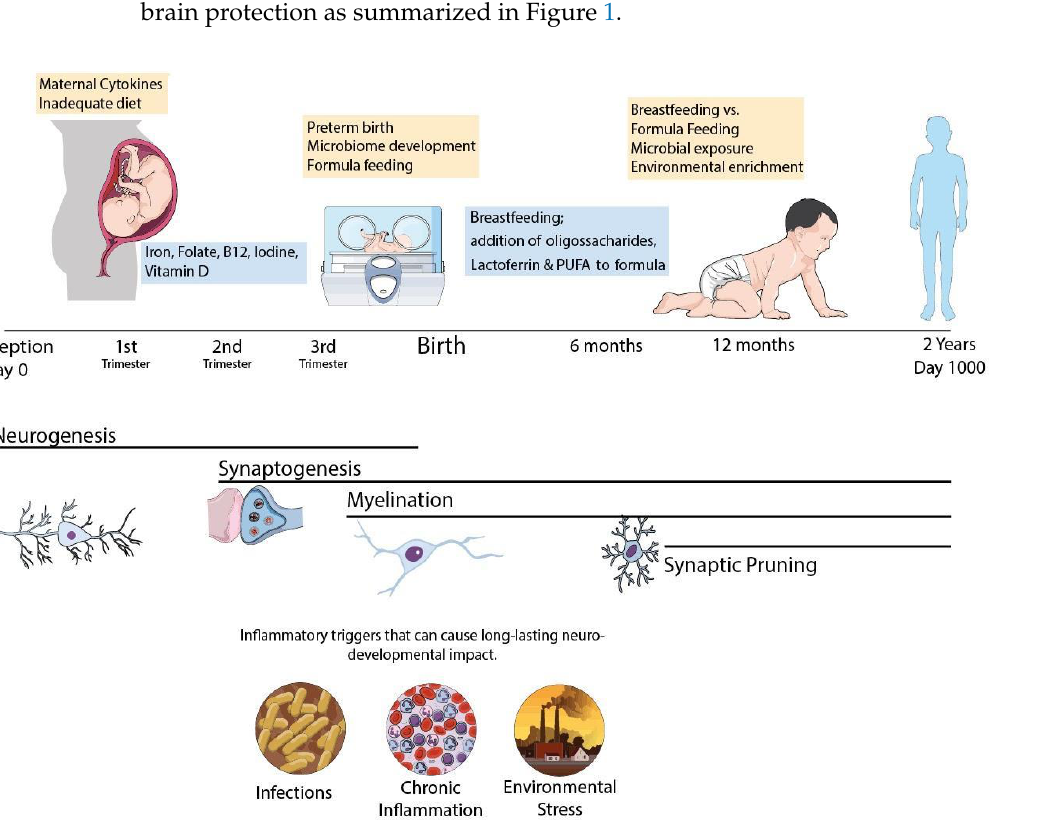
Figure 1 - Schematic representation of the CNS development in the first 1000 days period. Infant’s brain undergoes major hallmarks of neurodevelopment during this period and can be affected by poor nutrition, infectious pathogens and pollutants with life lasting consequences. Common neurodevelopmental disorders involve myelination disturbances (IUGR, prematurity) or synaptic pruning failure such as Autism Spectrum Disorder and Schizophrenia and can be triggered by early life events during brain maturation. Nutritional policies can be adopted to improve outcomes, with proper macro and micronutrient adequacy. Specific macronutrients such as Lactoferrin and n-3 polyunsaturated fatty acids have promising benefits for neurodevelopment and should be further explored in clinical